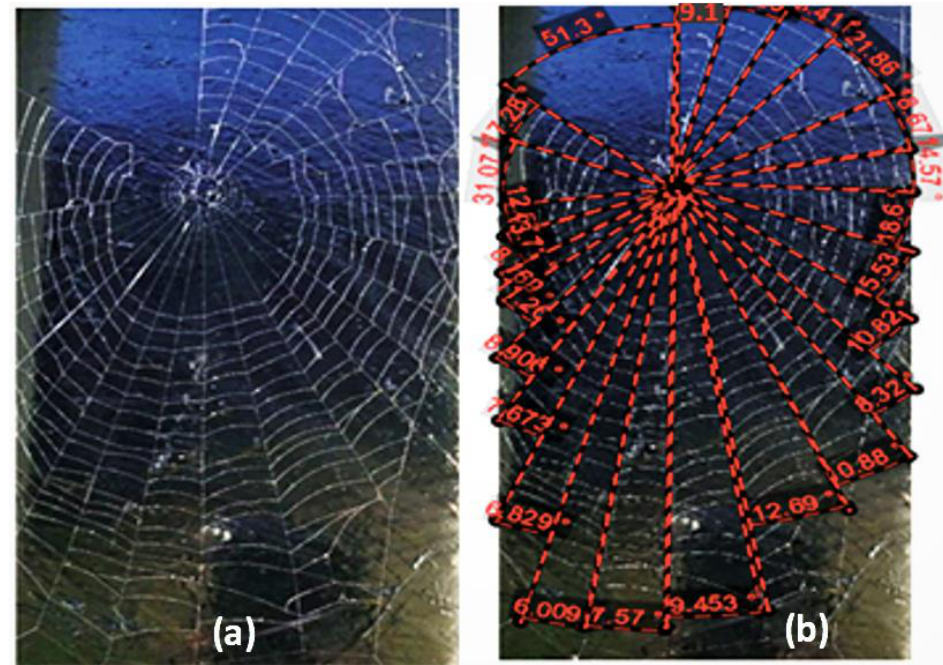
Figure 4. ( a ) Unmeasured image ( b ) measured image of SP3.